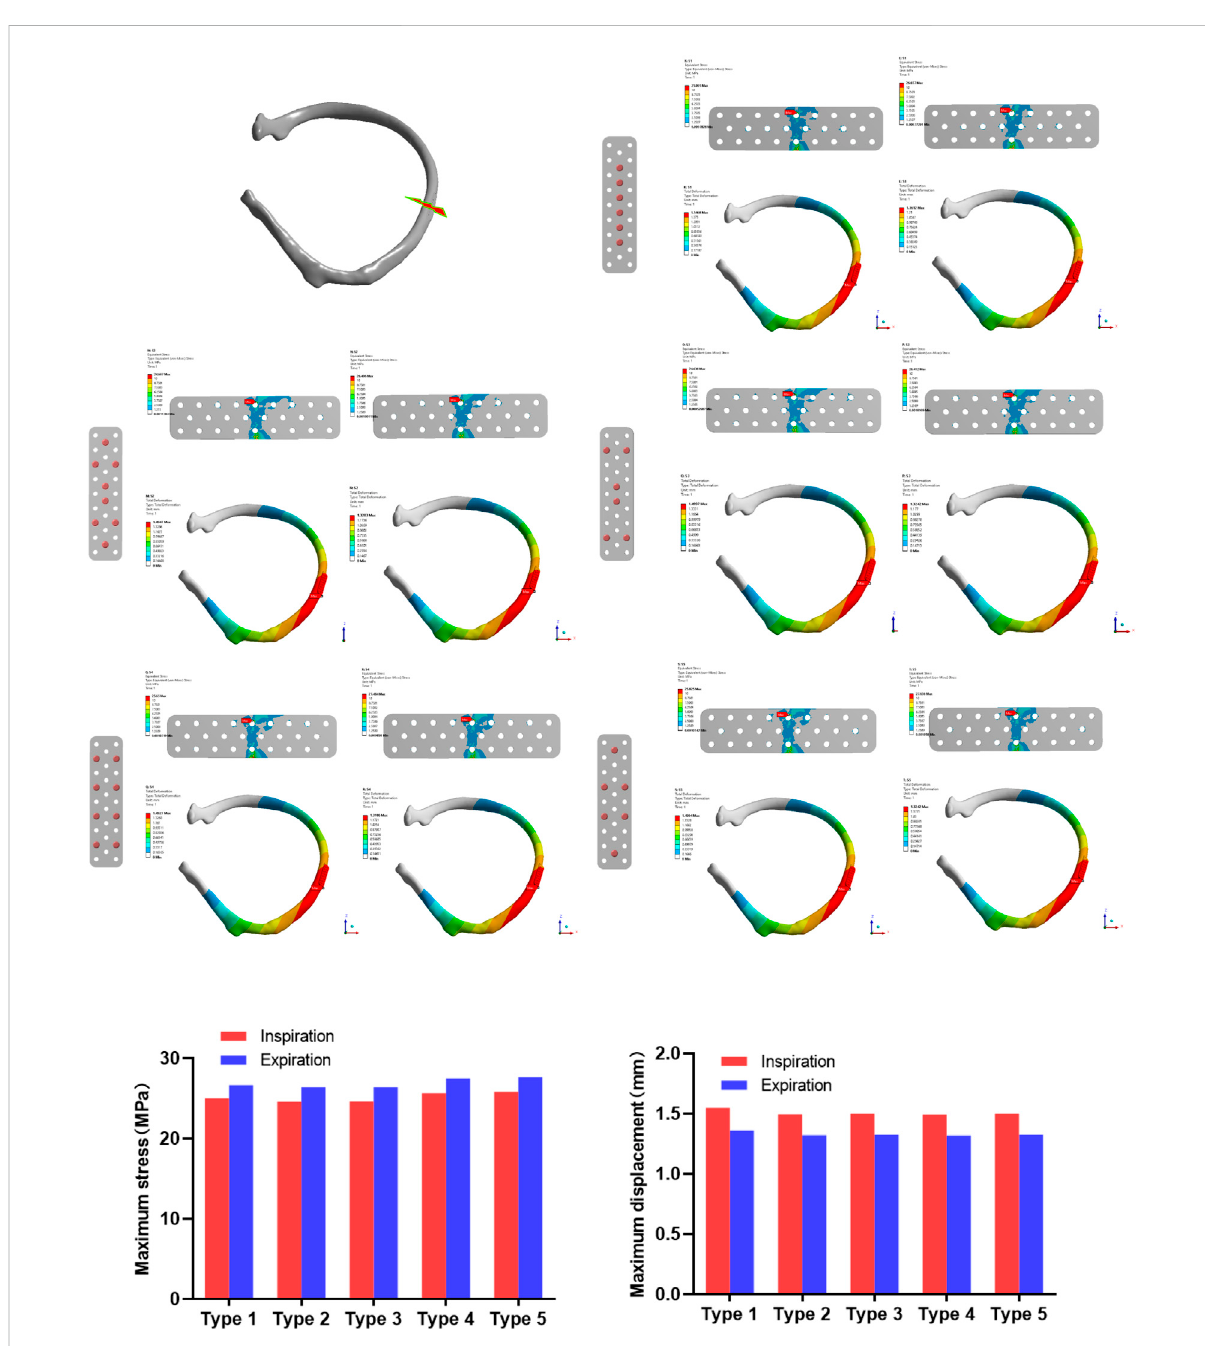
FIGURE 4 The maximum stress and displacement during inhalation and exhalation after the lateral rib fracture with different screw fi xation